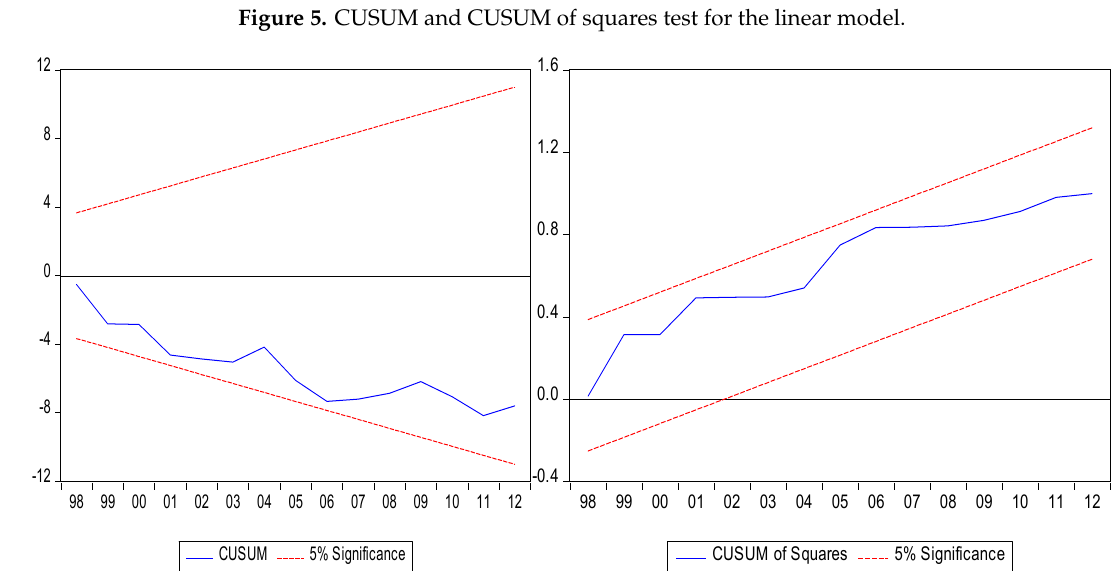
Figure 6. CUSUM and CUSUM of squares test for the squared model.